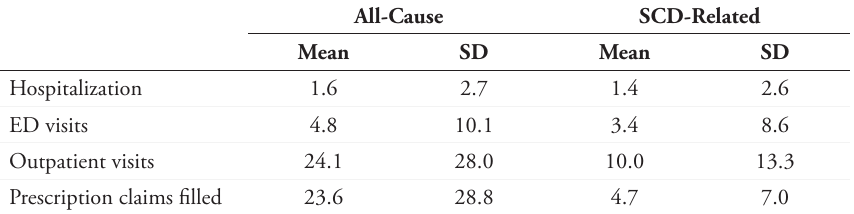
Table 5. All-Cause and Disease-Related Health Care Utilization among Patients with SCD (N = 3368)